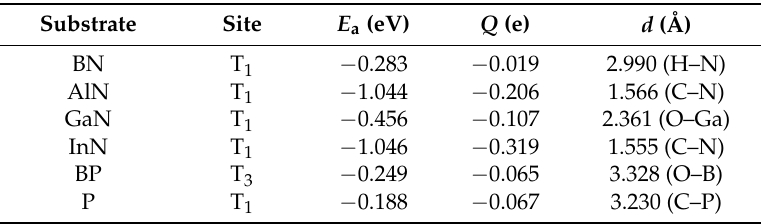
Table 1. E a , Q , and d of the gas adsorption systems of CH 2 O adsorbed on the BN, AlN, GaN, InN, BP, and P